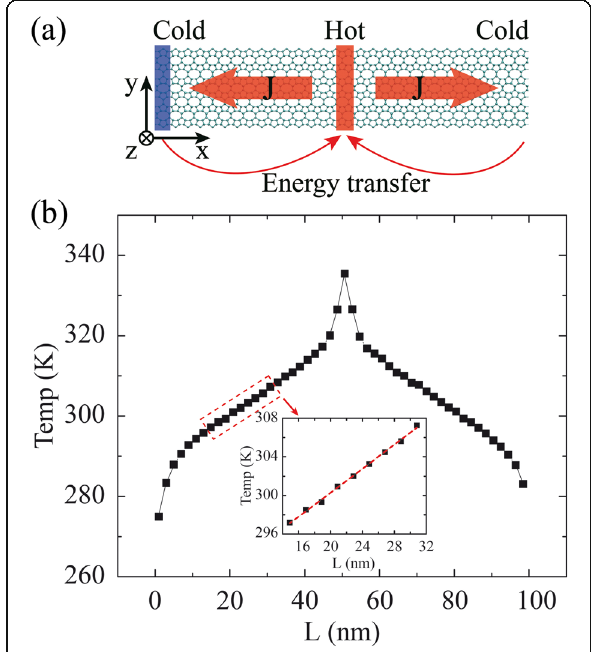
Fig. 2 a Schematic plot of the rNEMD method. The heat flux transfers from the heat source (hot region) to the heat sink (cold region). The heat flux transport direction is defined as the length direction (L) while the transverse direction is the width (W) direction. b The distribution of average temperature as a function of the